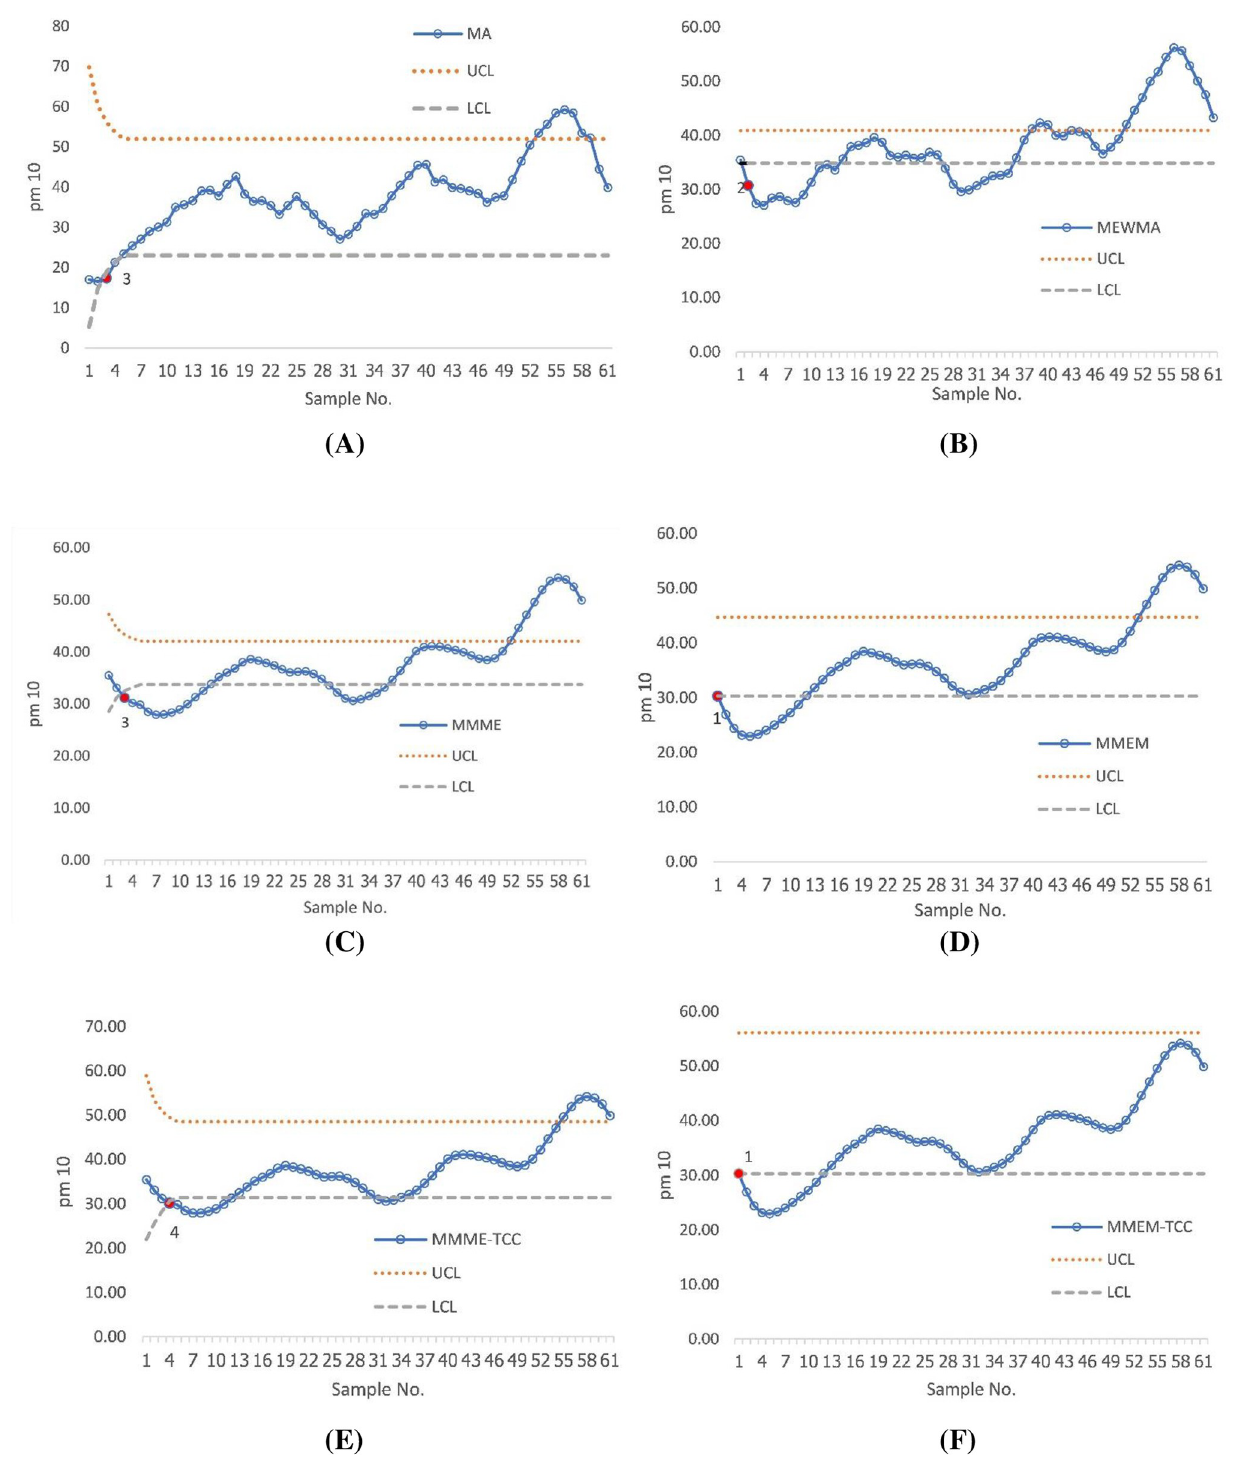
Fig 6. Displays of the PM 10 data set for the existing control chart (A) MA chart, (B) MEWMA chart, (C) MMME chart, (D) MMEM chart, (E) MMME-TCC, and (F) the proposed